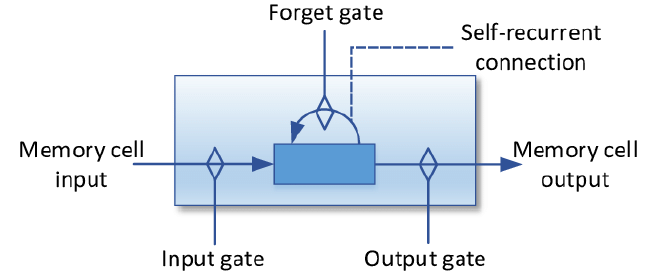
Figure 3. LSTM memory cell illustration [35,36].